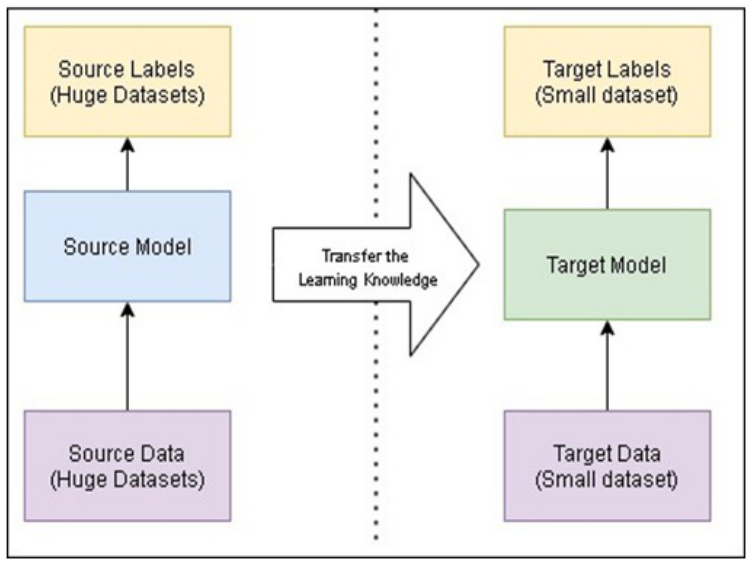
Figure 1. Idea of Transfer Learning (TL).